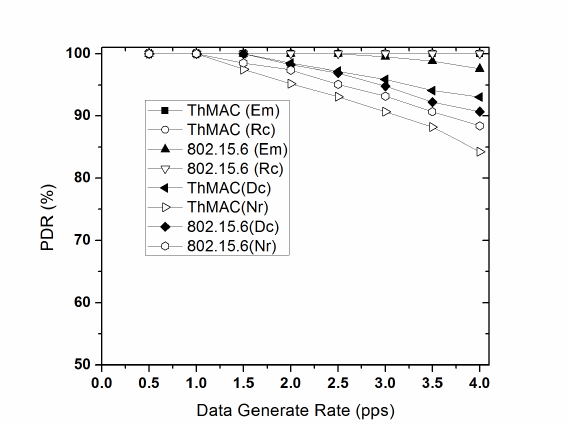
Figure 16. Packet delivery ratio varying data generation rate.